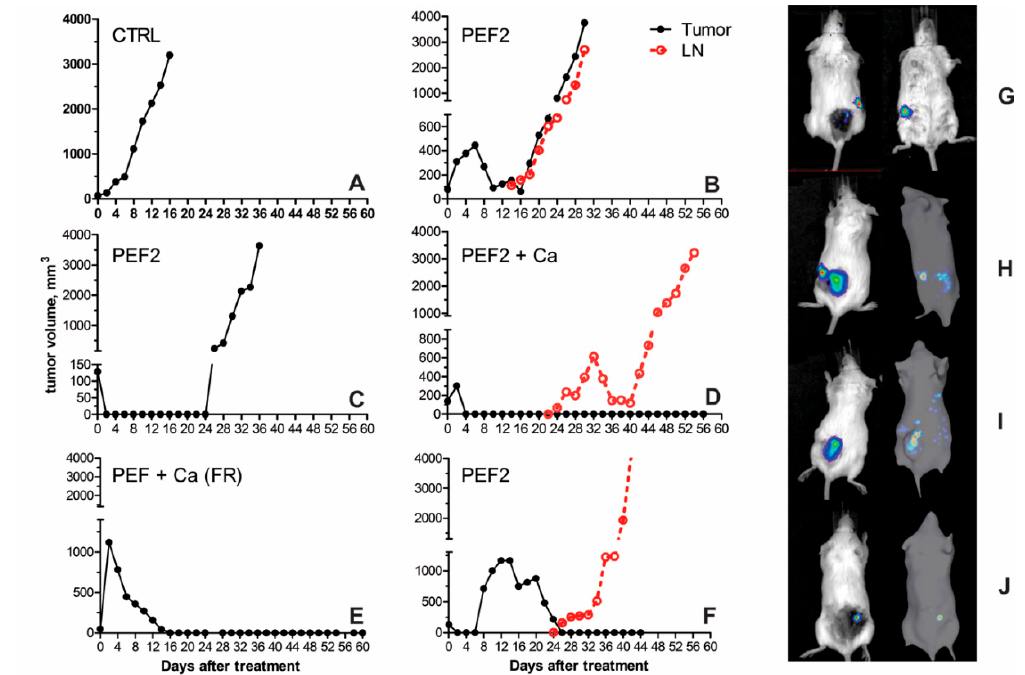
Figure 5. Examples of dynamics of tumor and metastases development in SP2/0 Luc myeloma tumors bearing mice with and without pulsed electric field (PEF) treatment, where ( A – F ) mice cases to highlight the heterogeneity in response to the treatments; ( G – J ) exemplary 2D and 3D images of metastases development and/or primary tumor regrowth.